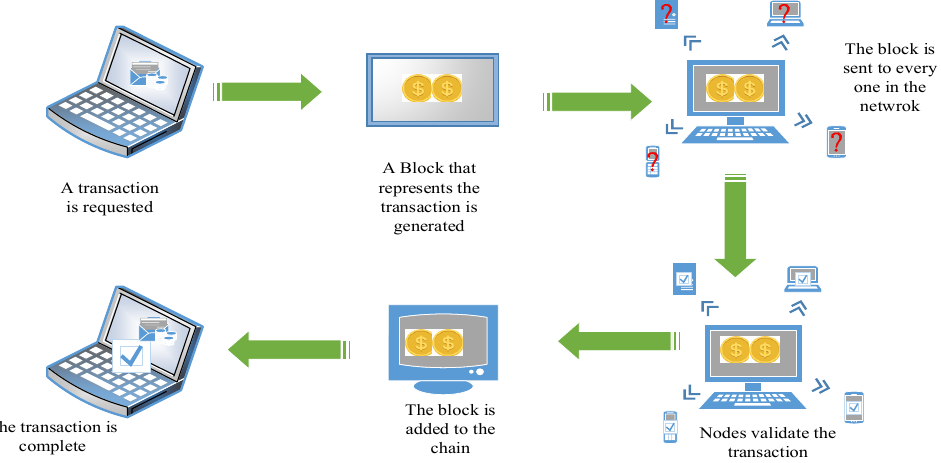
Figure 1. A diagram summarizing how blockchain works.